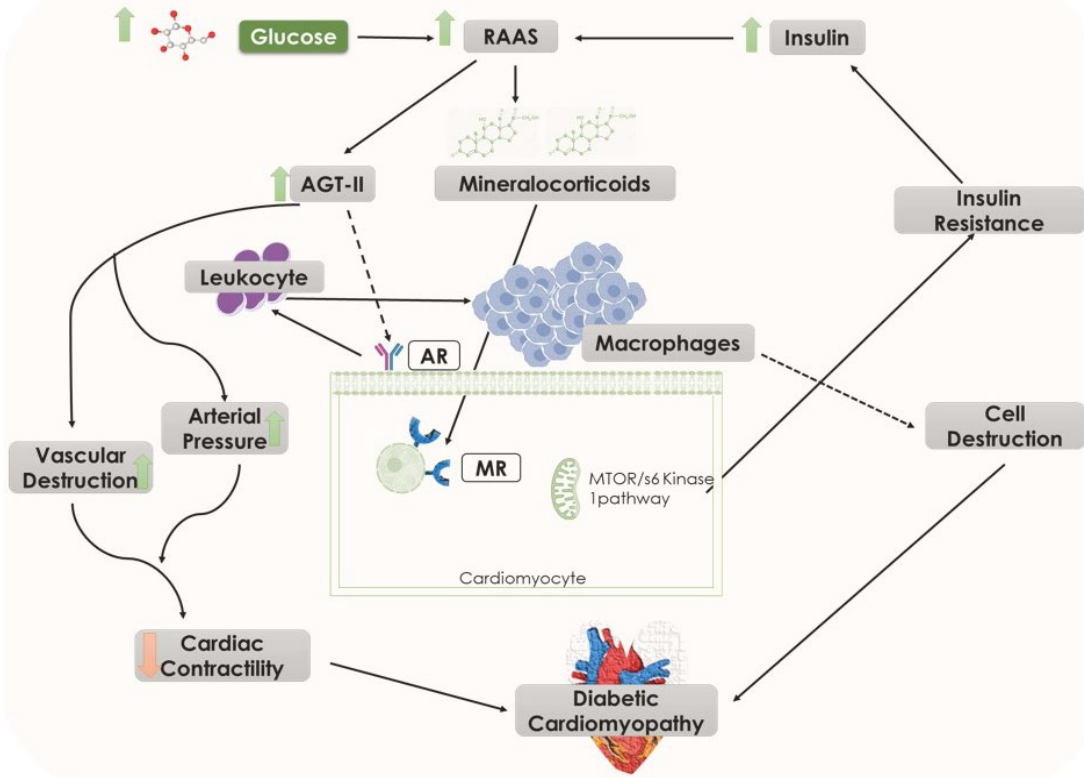
Figure 4. Illustrating the role of increased glucose levels in diabetic cardiomyopathy through ele- vated RAAS pathway. Black arrows represent downstream events and black dotted arrows also represent downstream events however several steps are involved. AGT-II, angiotensin II; AR, angi- otensin receptor; MR, mineralocorticoid receptor; RAAS, renin–angiotensin–aldosterone